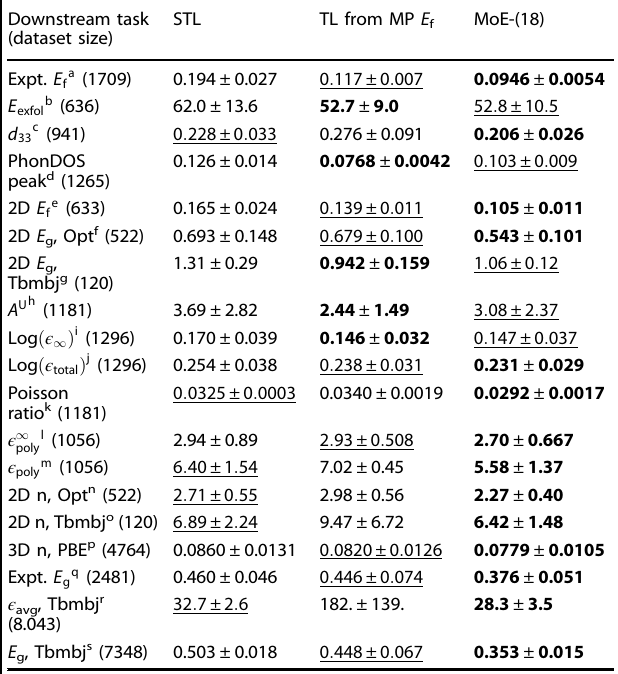
Table 3. Benchmarking MoE on 19 data-scarce regression tasks. Downstream task (dataset size)